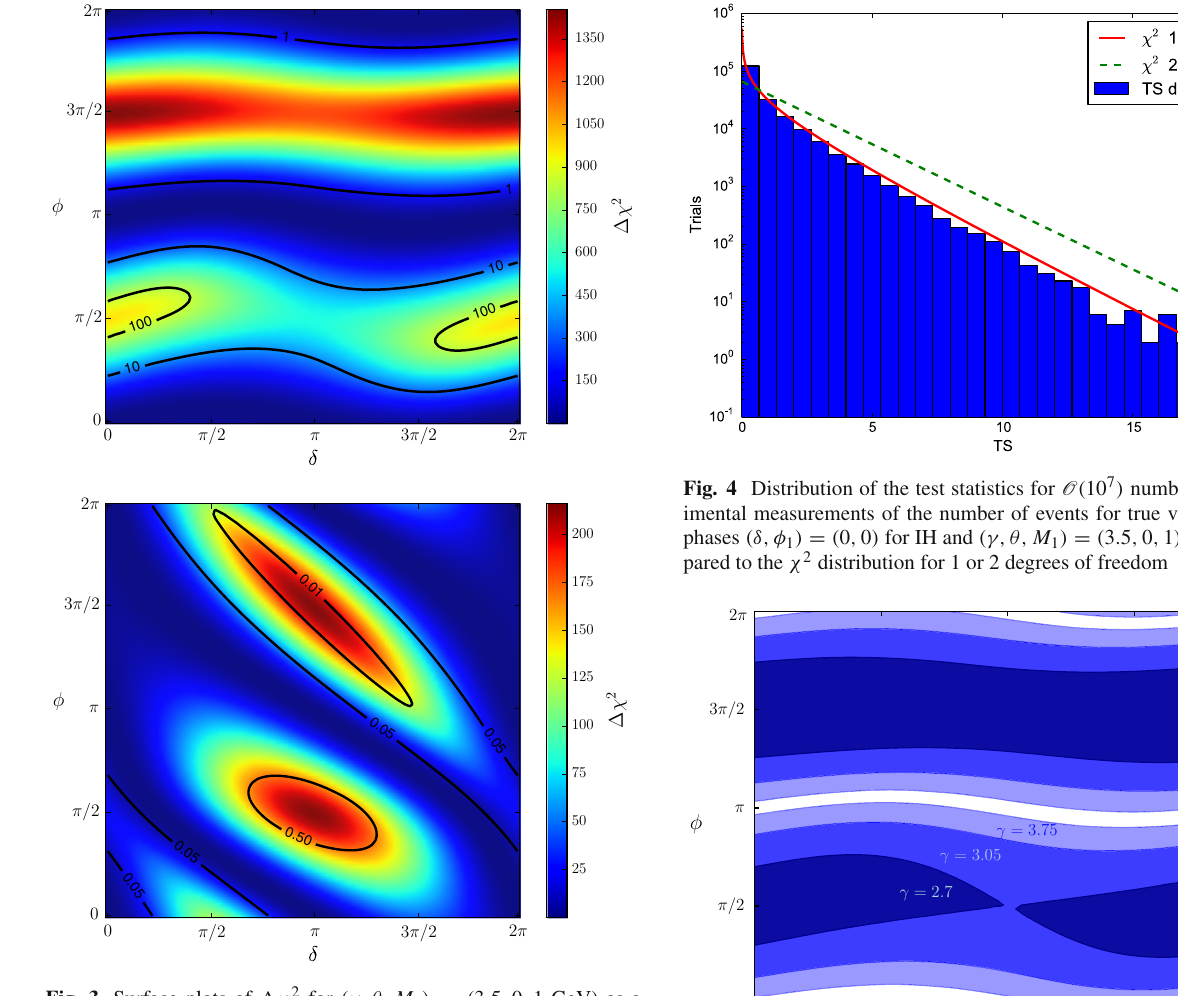
Fig. 3 Surface plots of (cid:9)χ 2 for (γ,θ, M 1 ) = ( 3 . 5 , 0 , 1 GeV) as a function of the true (δ,φ 1 ) of IH ( up ) and NH ( down ) for SHiP. The lines correspond to the constant value indicated of the ratio of electron– muon mixing as obtained from the analytical formulae of Eqs. (6) and (7)